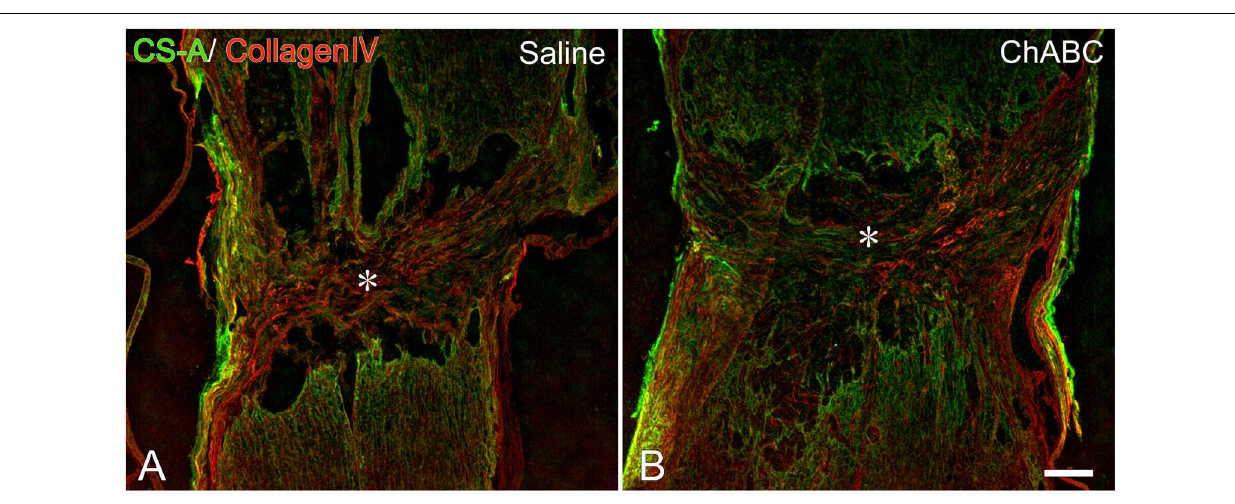
Frontiers in Integrative Neuroscience |